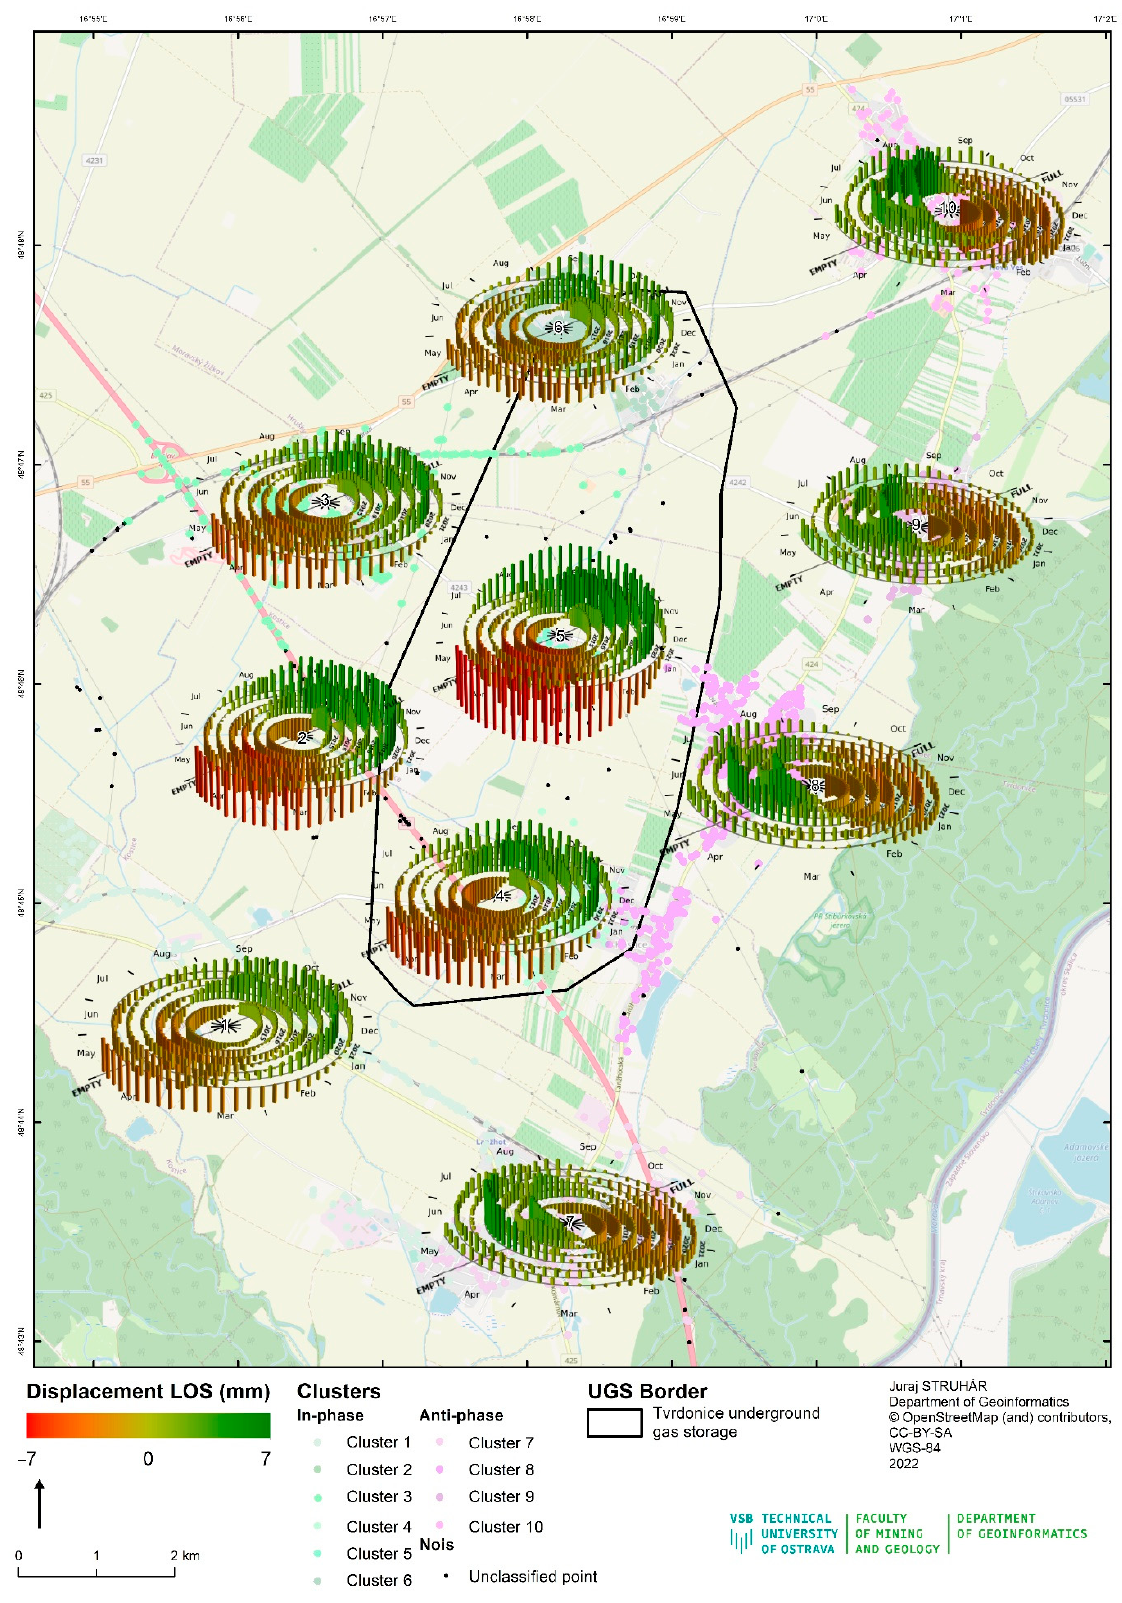
Figure A6. Map composition from Figure A1 showing the distribution of spiral plots in 3D over the cluster centroids; data used were smoothed by a simple moving average with a 90 ‐ day window.